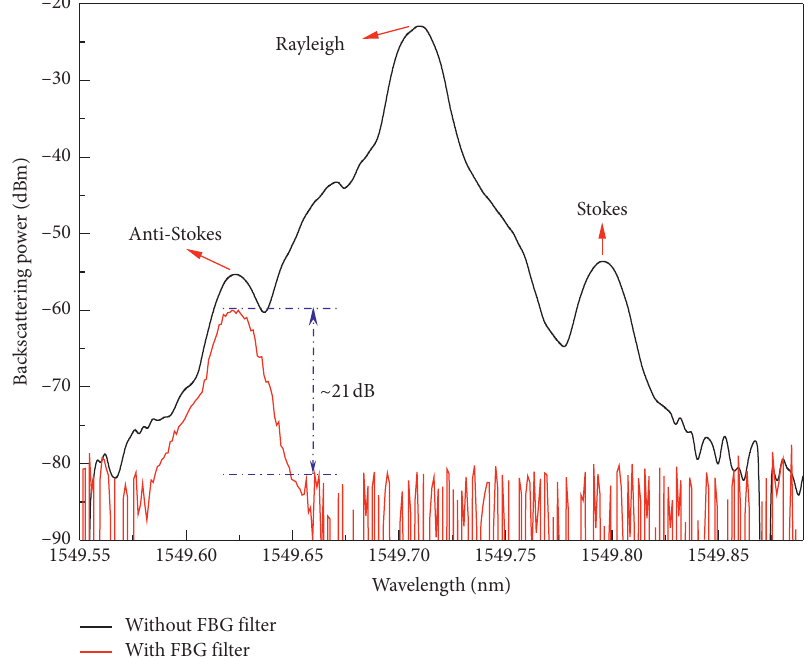
Figure 5: Measuring the backscattered spectra with and without the cascading FBG filter.